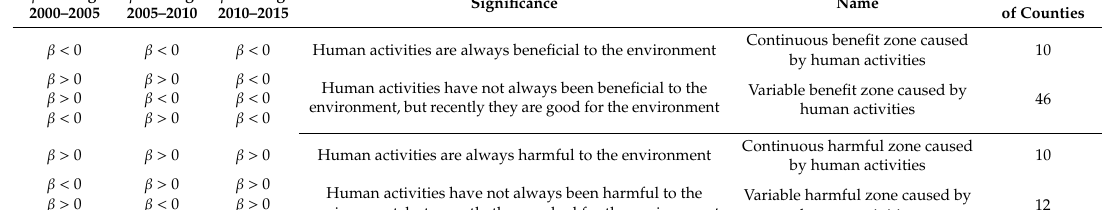
Table 5. Classification method according to the relationship between LVI and LHAI.